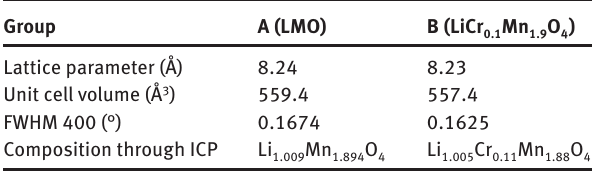
Table 1: Average lattice constants and FWHMs at (4 0 0) Group